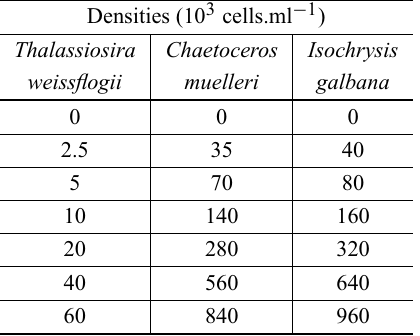
Algal densities used in the experiments to measure egg production in the copepod Acartia tonsa . Algae densities are equivalent in